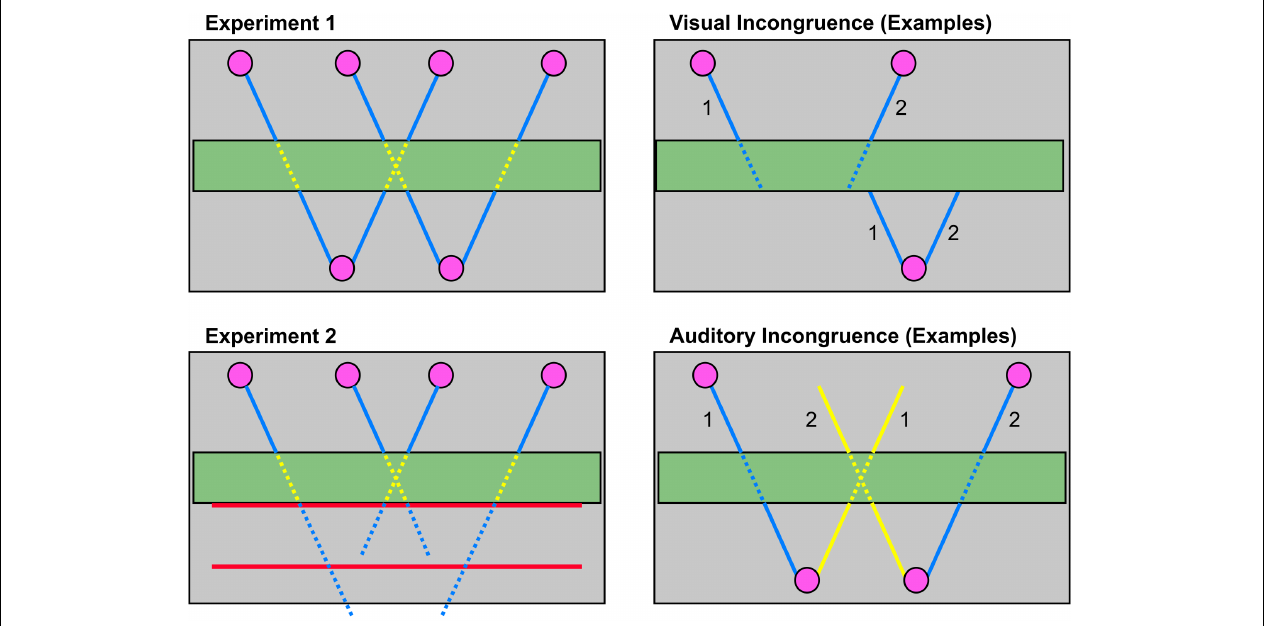
FIGURE 2 | Illustration of visual trajectories and auditory stimulation (left) as well as visual and auditory incongruent trials (right). The left panel shows all 4 visual trajectories (left, middle left, middle right, right) viewed from above. Continuous lines illustrate a visible moving ball whereas dotted lines represent invisible ball movements (during occlusion in experiment 1, for experiment 2 as well after occlusion). In audiovisual trials the ball’s movement was accompanied by sounds (blue). During occlusion period the sound was attenuated (yellow). During audiovisual trials sounds always started with the beginning of visual motion. Auditory motion ended with the ball’s movement in experiment 1. In experiment 2 the auditory movement continued for 1533 ms after the ball would have reached the red bar for near and far extrapolation (illustrated by different line lengths for the outer and inner trajectories in the lower left panel). During visual incongruent trials the ball did not reappear on a consistent path after occlusion but rather reappeared on the second possible path for that direction. See upper right panel for two examples: Ball 1 started on the left, ball 2 on the middle right trajectory. In visual incongruent trials ball 1 reappeared on the middle left and ball 2 on the right trajectory. For auditory incongruent trials a sound was presented that moved in the opposite direction as the visual stimulation (lower right panel). Two examples are illustrated here: Ball 1 moves on the visual left, ball 2 on the right trajectory, ball 1 is accompanied by a sound moving on the middle right trajectory, ball 2 is accompanied by a sound on the middle left trajectory. To keep constant the distance of inconsistent auditory motion an outer visual trajectory was always paired with a middle trajectory moving in the opposite direction as the visual movement and the middle trajectories were paired with inconsistent outer auditory trajectories,